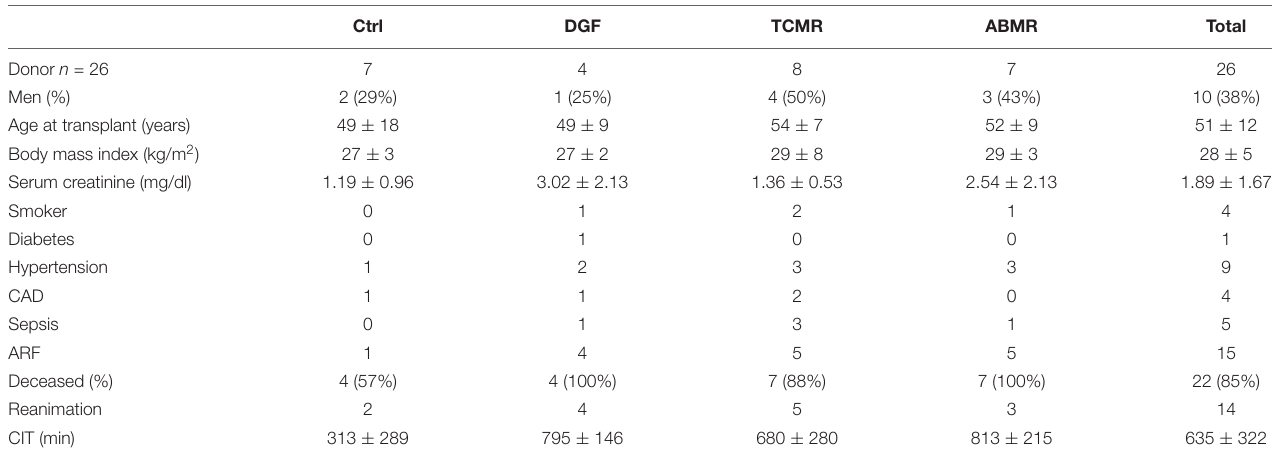
TABLE 1 | Kidney donor characteristics.